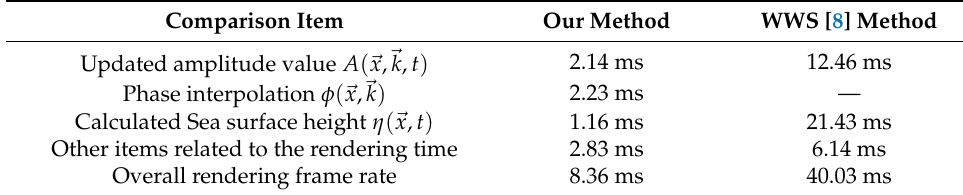
Table 2. Performance for a single frame.